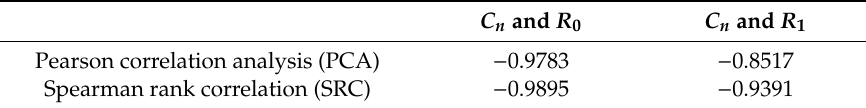
Table 2. Correlations between the capacity and resistance.